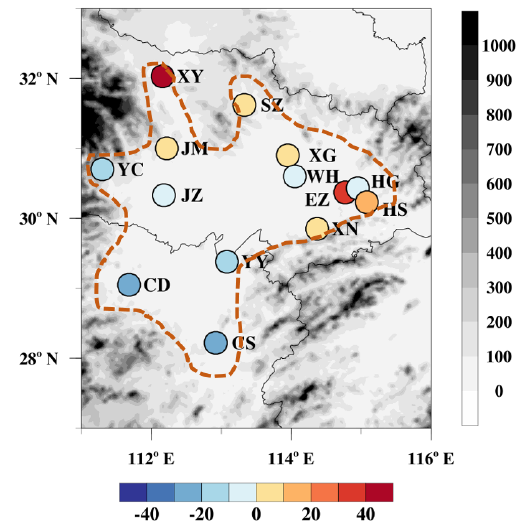
Figure 9. Spatial distribution of contribution rates (colored dots, unit: %) of meteorological variations regarding PM 2 . 5 reductions with topographical height (color contours, ma.s.l.) in the THB (out- lined with orange dashed line) and surrounding regions from 2015 to